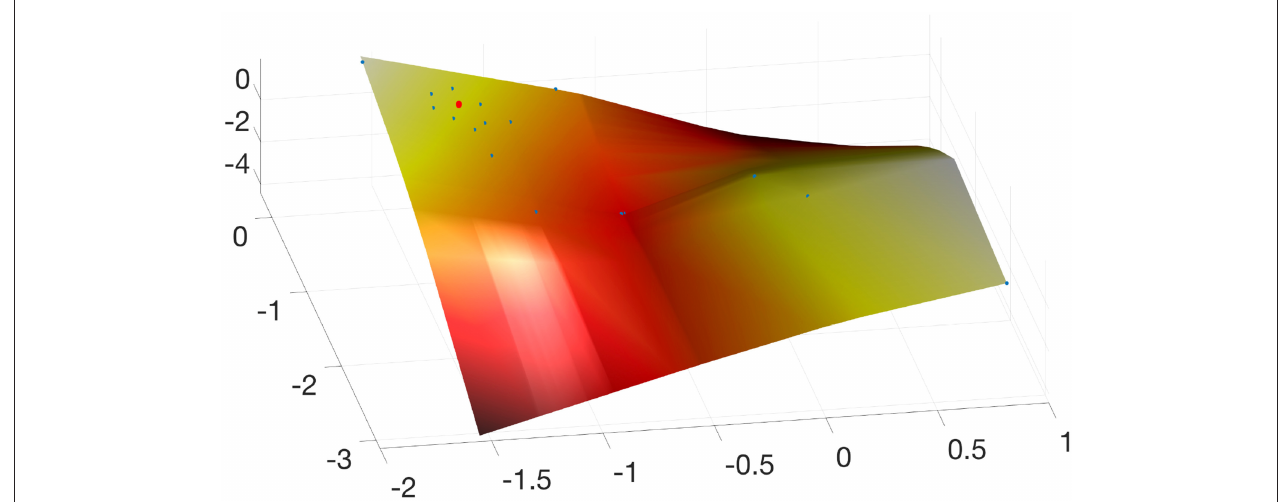
FIGURE 6 | Obtained constitutive manifold by embedding the experimental results onto a three-dimensional space. Only a portion of the 557 experimental results are shown for clarity. In red, control point employed to validate the approach. Note that it is surrounded by a user-defined number of neighbors, whose GENERIC model is employed to obtain, by interpolation by means of the LLE weights, the sought model.